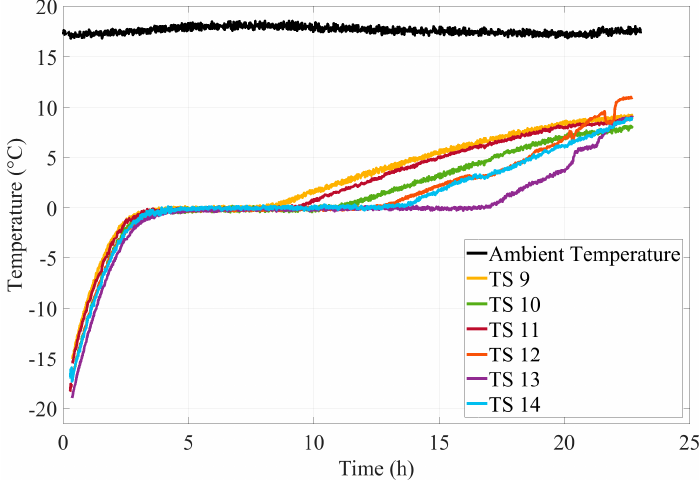
Figure 8. Time history of the temperature profile of the PT100 sensors in the soil; positions are according to Figure 6.